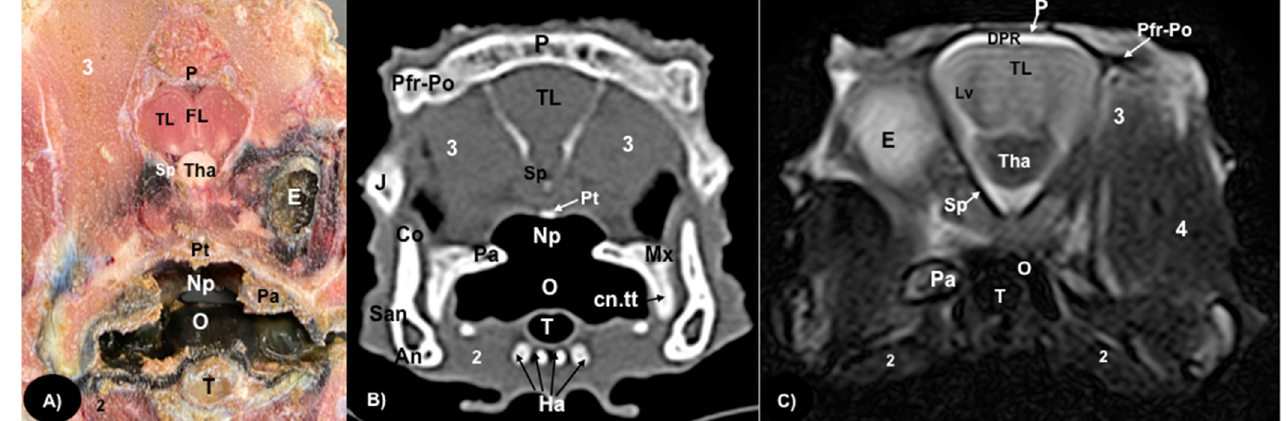
5 of 12 Figure 3. Transversal gross ‐ section ( A ), CT bone window ( B ), and MRI in T2W ( C ), images of the